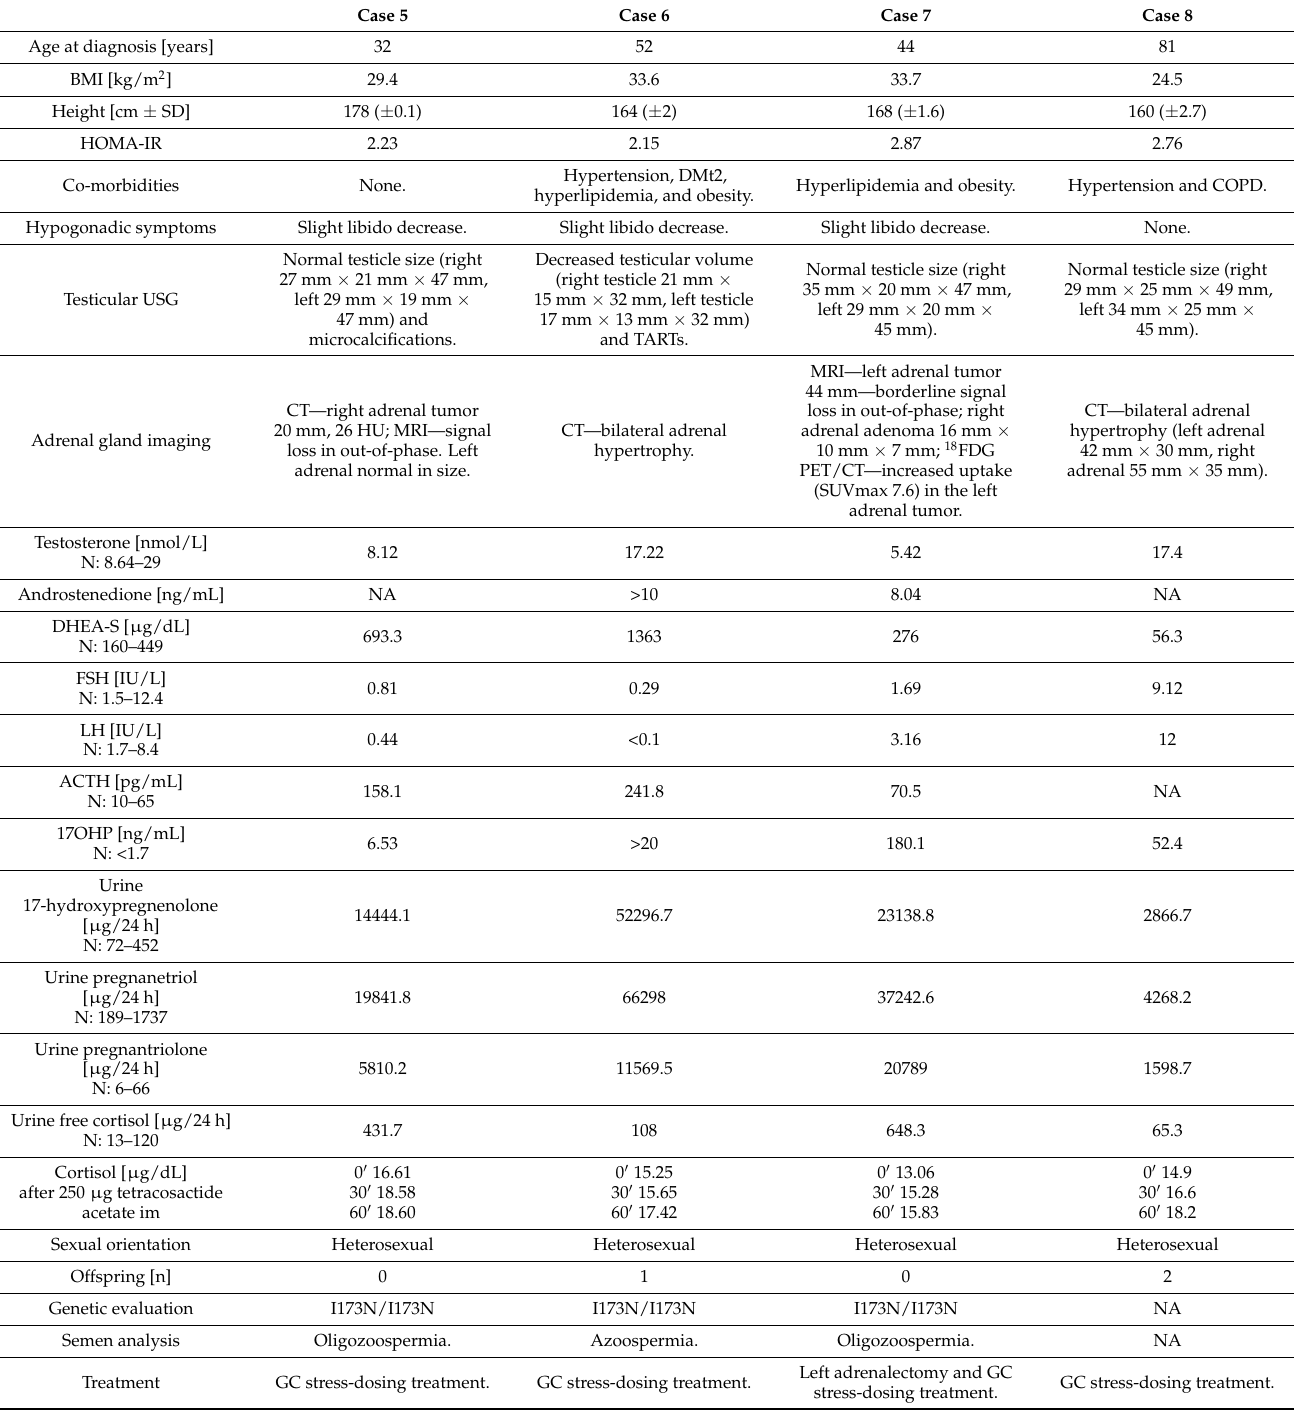
Table 2. Characteristics of male patients with